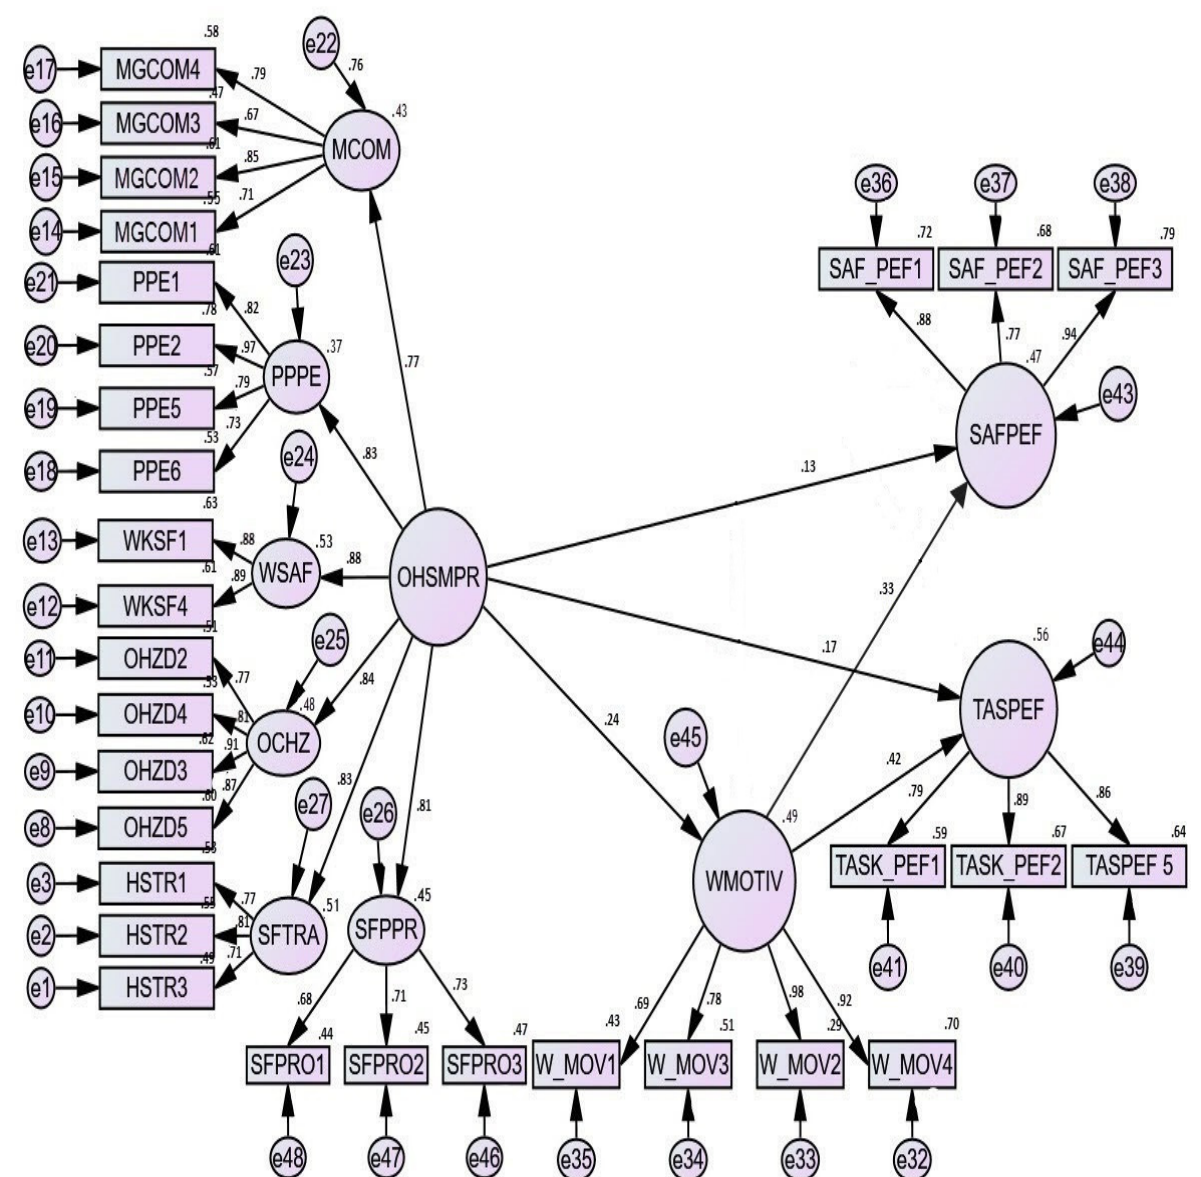
Figure 2. Structural Equation Model.